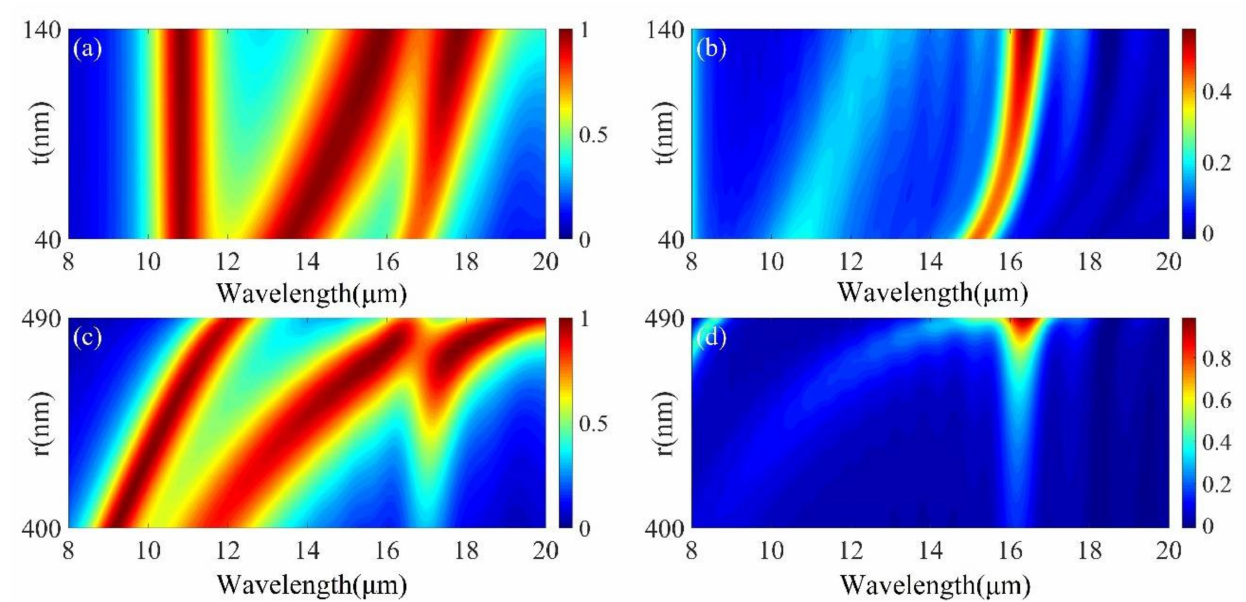
Figure 5. ( a , b ) Absorption patterns of Al 2 O 3 layers with crystalline and amorphous phases at different heights. ( c , d ) Ab- sorption patterns of various radiuses of Mo arrays with crystalline and amorphous phases, respectively. The other geometric parameters are the same as in Figure 2.